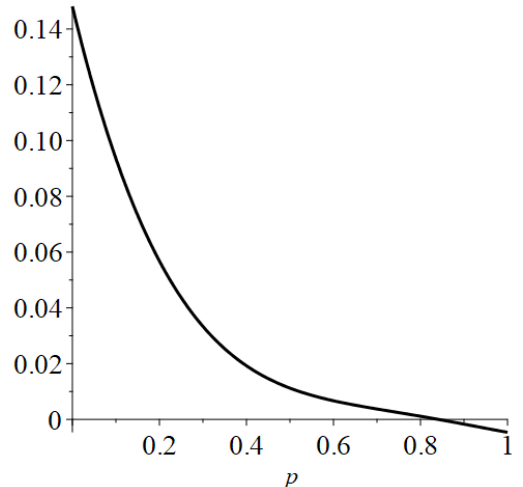
Figure 8. Simulation of the profit difference between the hybrid platform mode and the merchant mode.